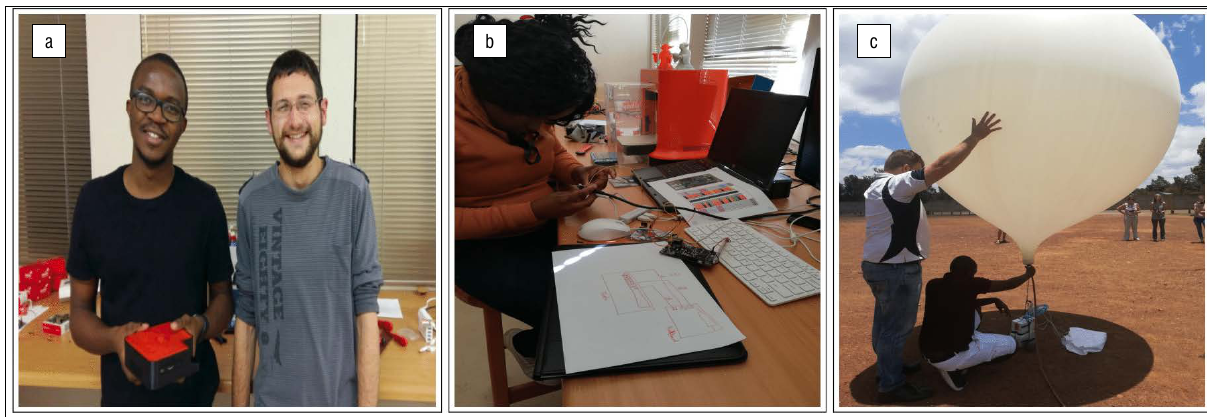
High-altitude balloon flight measurements Aside from the scientific consideration, there is much more to be taken into consideration, such as applying for permission to launch the balloon from the Air Traffic and Navigation Services (ATNS) (https://www.atns. com/) – an entity of the South African Department of Transport. Prior to launching, the following equipment must be available: a meteorological rubber balloon, helium/hydrogen gas, an insulated payload box, detection system, location mapping tracker, and a parachute. All the instruments used are mounted inside, except the camera. The detector is tracked by placing a smartphone inside the box and using the standard tracking software of the phone.